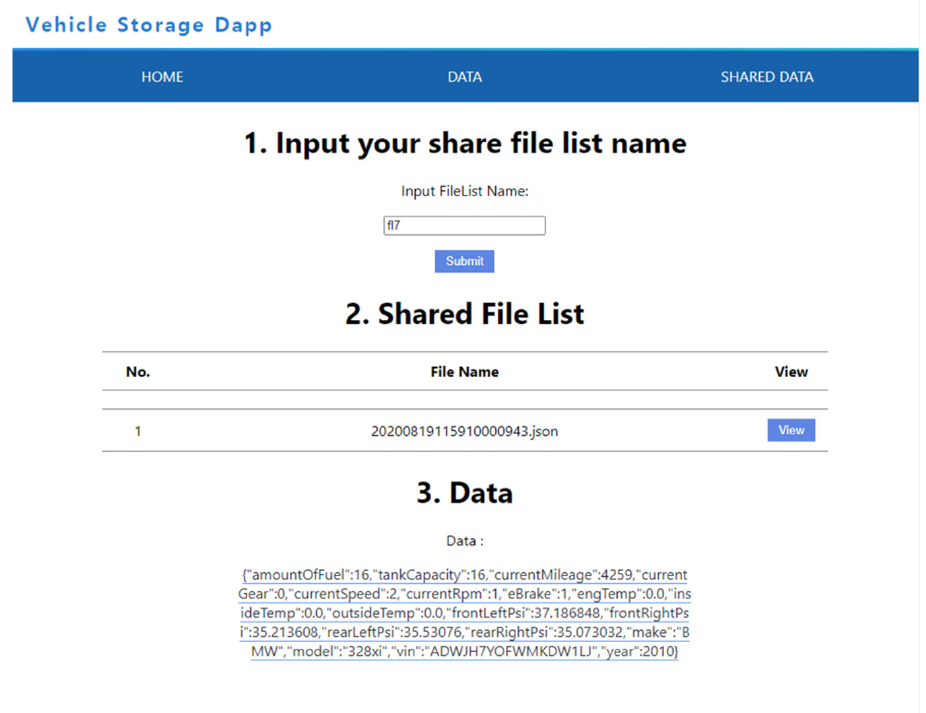
Figure 9. Share Data page.